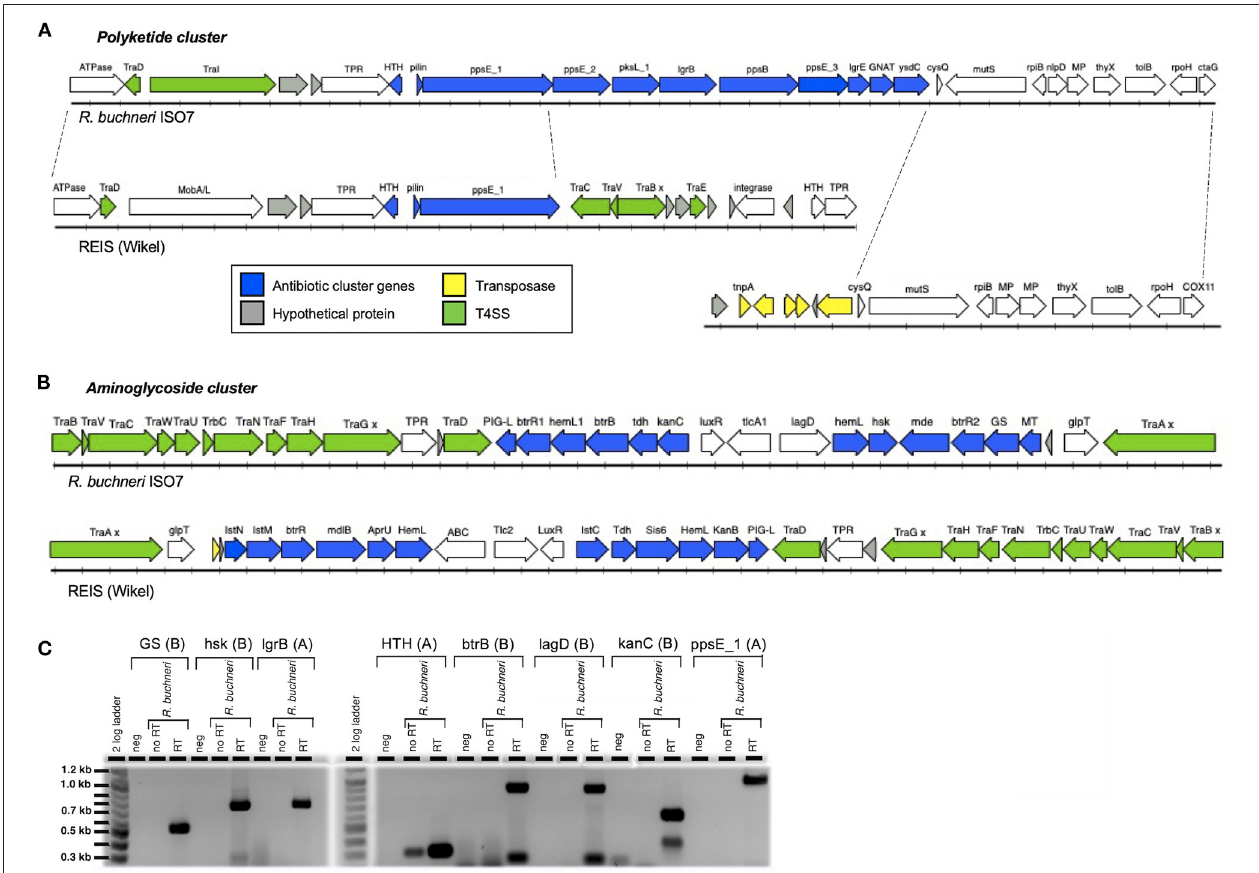
FIGURE 3 | Antibiotic gene clusters in Rickettsia buchneri. Diagrams showing the gene arrangement of R. buchneri ISO7 antibiotic gene clusters containing polyketide (A) and aminoglycoside (B) synthesis genes, and neighboring regions of the genome, and their comparison with those in the REIS (Wikel) genome. GS—glycogen synthase; hsk—homoserine kinase; MT—methyltransferase; MP—metallopeptidase; x denotes a mutation resulting in a truncation. (C) RT-PCR of R. buchneri ISO7 RNA showing the transcription of selected genes from antibiotic clusters. The gene product and antibiotic cluster (A = polyketide, B = aminoglycoside) are shown above the wells of the gel. See Tables 2 , 3 for additional